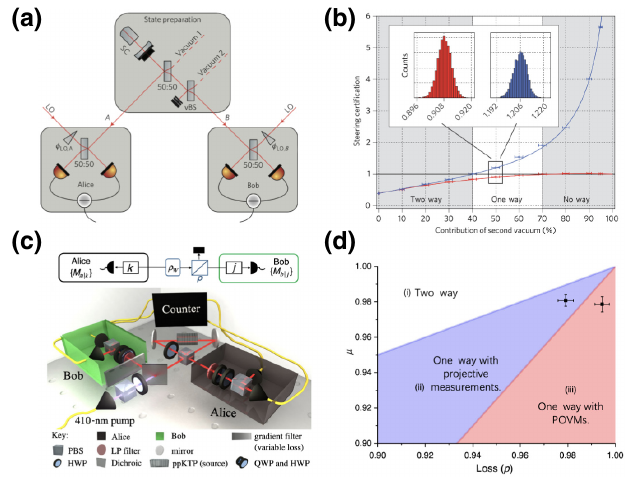
FIG. 1. Experimental demonstrations of one-way steering via linear optics and photonic systems. (a) Outline of the experi- mental arrangement of Händchen et al. [43] for realization of Gaussian one-way steering. (b) Certification of one-way steering in Ref. [43]. Measurement results of the inferred variance prod- ucts according to Reid criterion versus an increasing contribution of the added vacuum on mode B . (c) The experimental scheme of Wollmann et al. [46] to observe one-way steering in a qubit-qutrit system. (d) Three different steering regimes are parametrized by the purity of Werner state μ and the loss channel p . Reproduced from (a) and (b) Ref. [43], (c), (d) Ref.